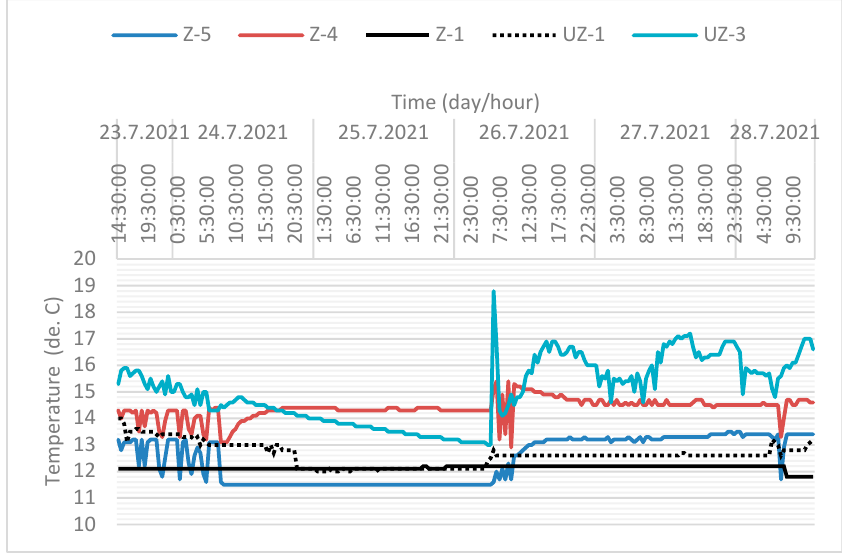
Figure 21. Groundwater temperatures during pumping in the observed wells.